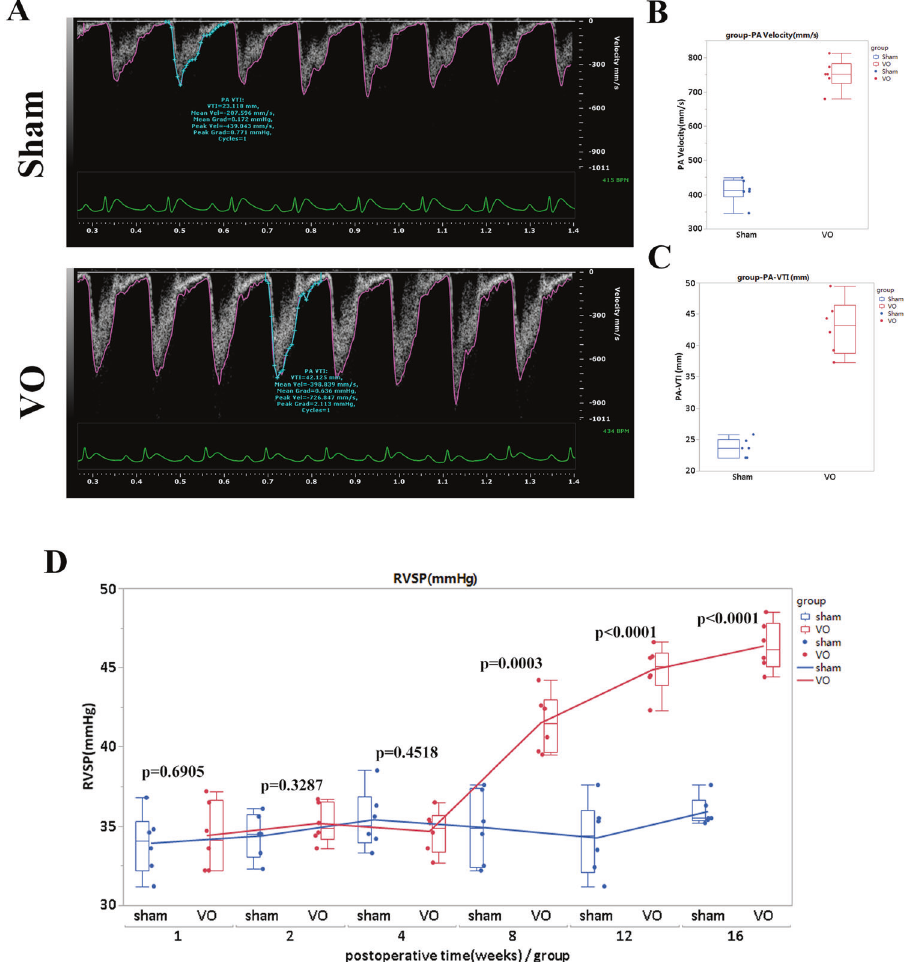
Fig. 2 Veri fi cation of VO in the AVF group. A Representative echocardiogram of pulmonary artery (PA) velocity and velocity-time integral (VTI) in the sham and VO groups. B Quanti fi cation of PA-velocity in the sham and VO groups, p < 0.0001, N = 6. C Quanti fi cation of PA-VTI in the sham and VO groups, p < 0.0001, N = 6. D RVSP changes over time. There were no signi fi cant differences between the sham and VO groups before 4 weeks after the AVF operation. RVSP right-ventricular systolic